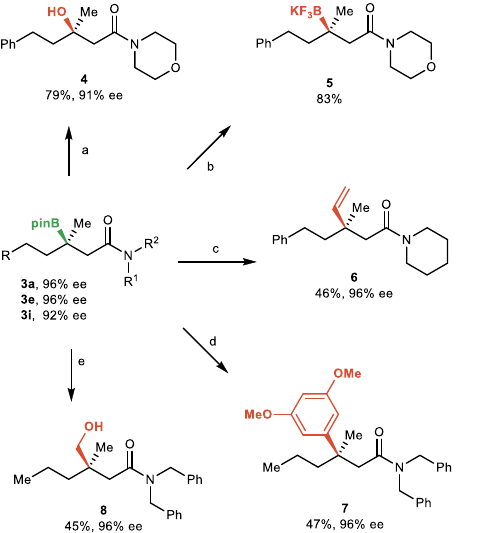
Fig. 4 Synthetic utility. Further transformations of the hydroboration products. Reaction conditions: a NaBO 3 , H 2 O, THF; b KHF 2 , MeCN, H 2 O; c (1) vinylMgBr, THF, r.t; (2) I 2 , MeOH, − 78 °C; (3) NaOMe, MeOH; d (1) 1- bromo-3,5-dimethoxybenzene, t BuLi, THF, − 78 °C; (2) NBS, THF, − 78 °C;